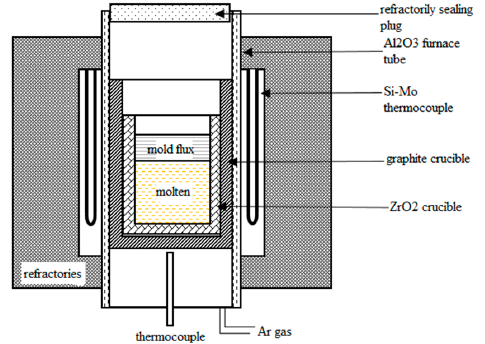
Figure 1. Schematic of the experimental apparatus.